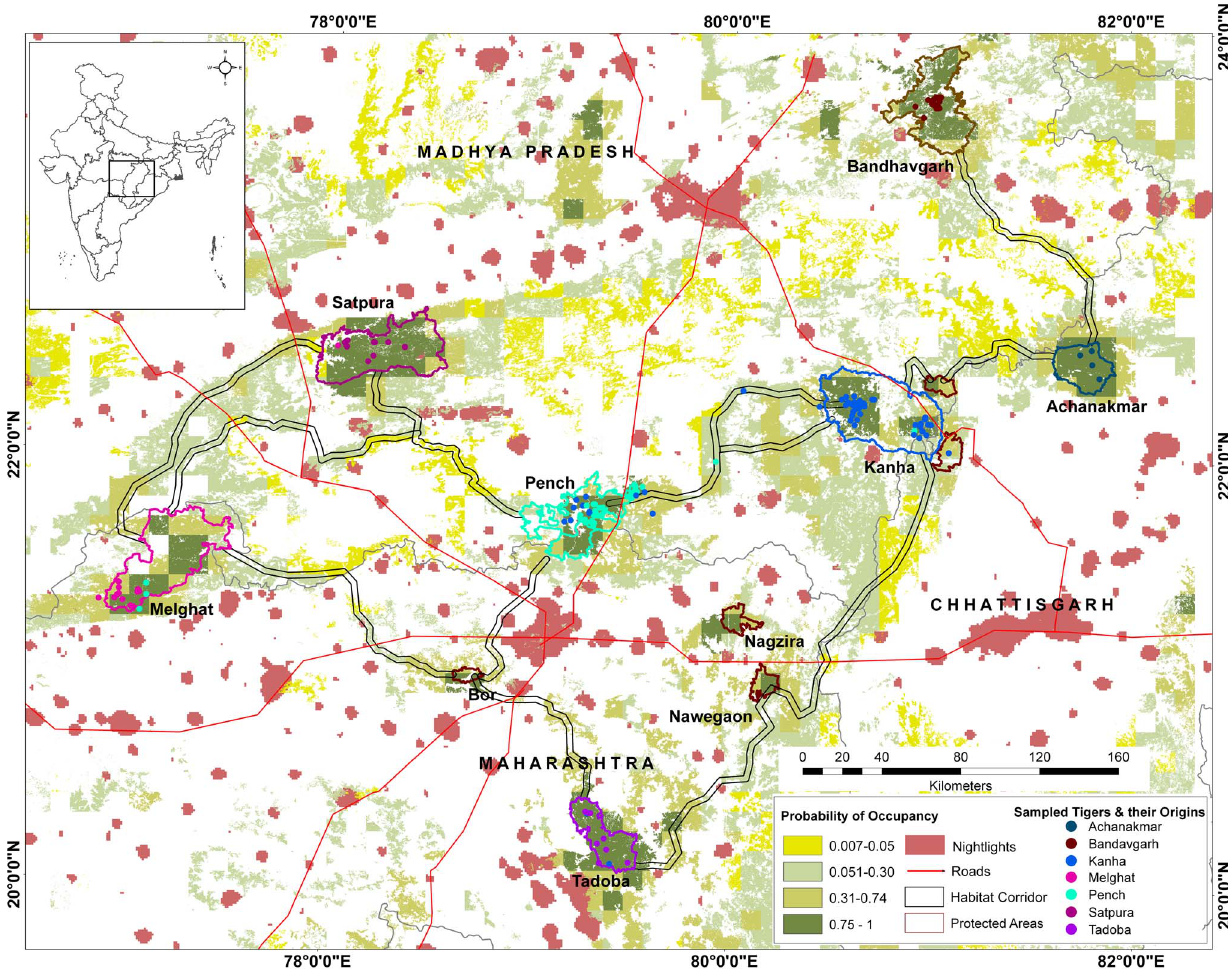
Figure 1. Study area map showing sampled sites, genotype locations and habitat connectivity. The study area of Central India spanning the states of Madhya Pradesh, Maharashtra and Chhattisgarh, showing tiger habitat (forest cover) coded with tiger occupancy probability, protected areas, human habitation (night lights), major roads and least-cost habitat corridors connecting tiger reserves. Individually genotyped tigers (n=165) are shown as color coded dots at their sampled locations with their colors matching their genetically assigned population.